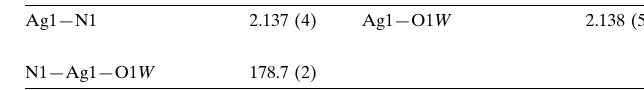
Selected geometric parameters (A˚ , (cid:3) ).